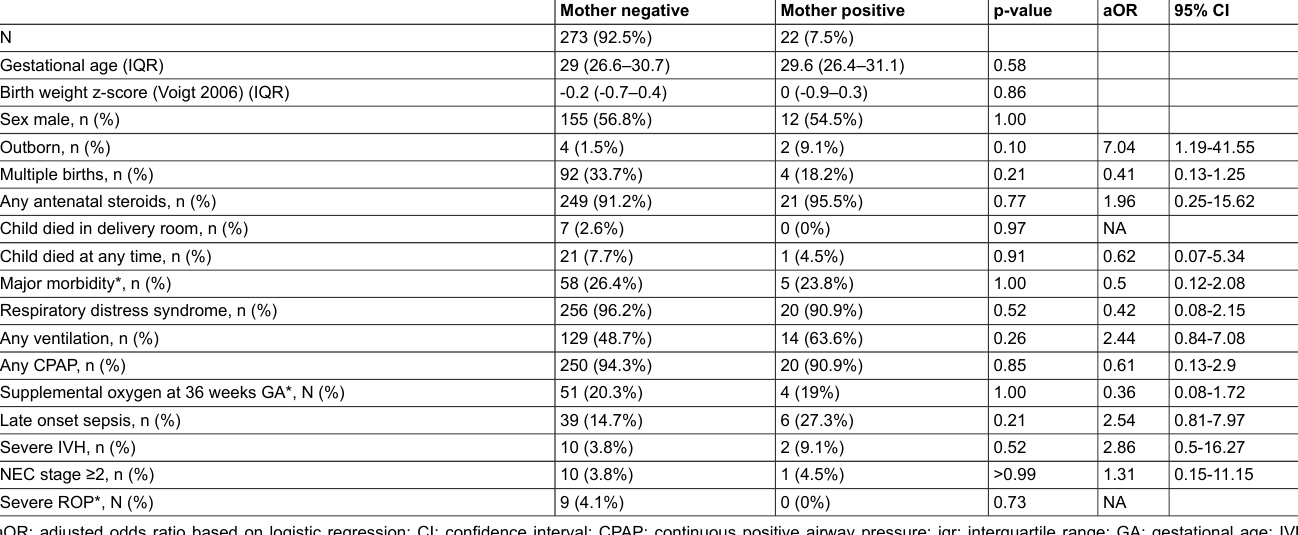
Table 3: Incidence, treatment and outcome of infants born with versus without confirmed maternal SARS-CoV-2